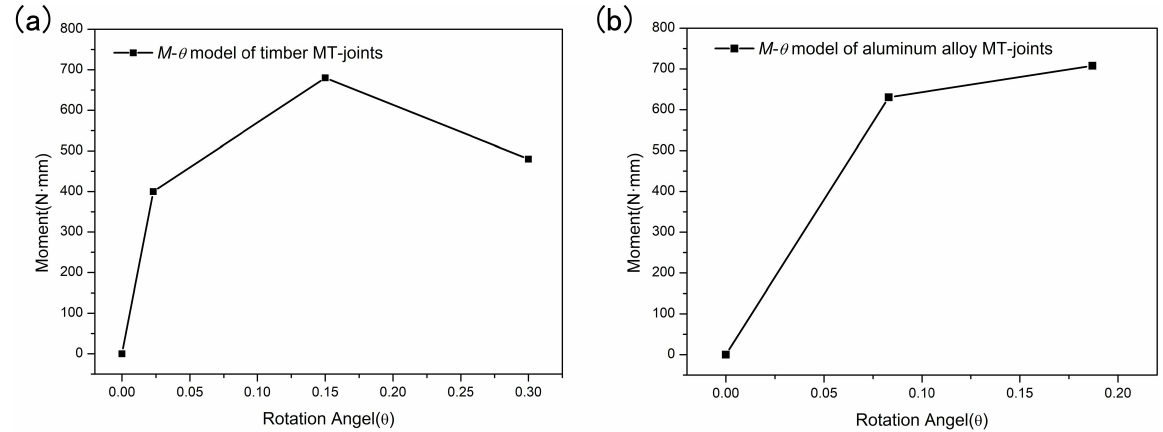
Figure 14: Comparison diagram between timber MT-T joint and aluminum alloy MT-T